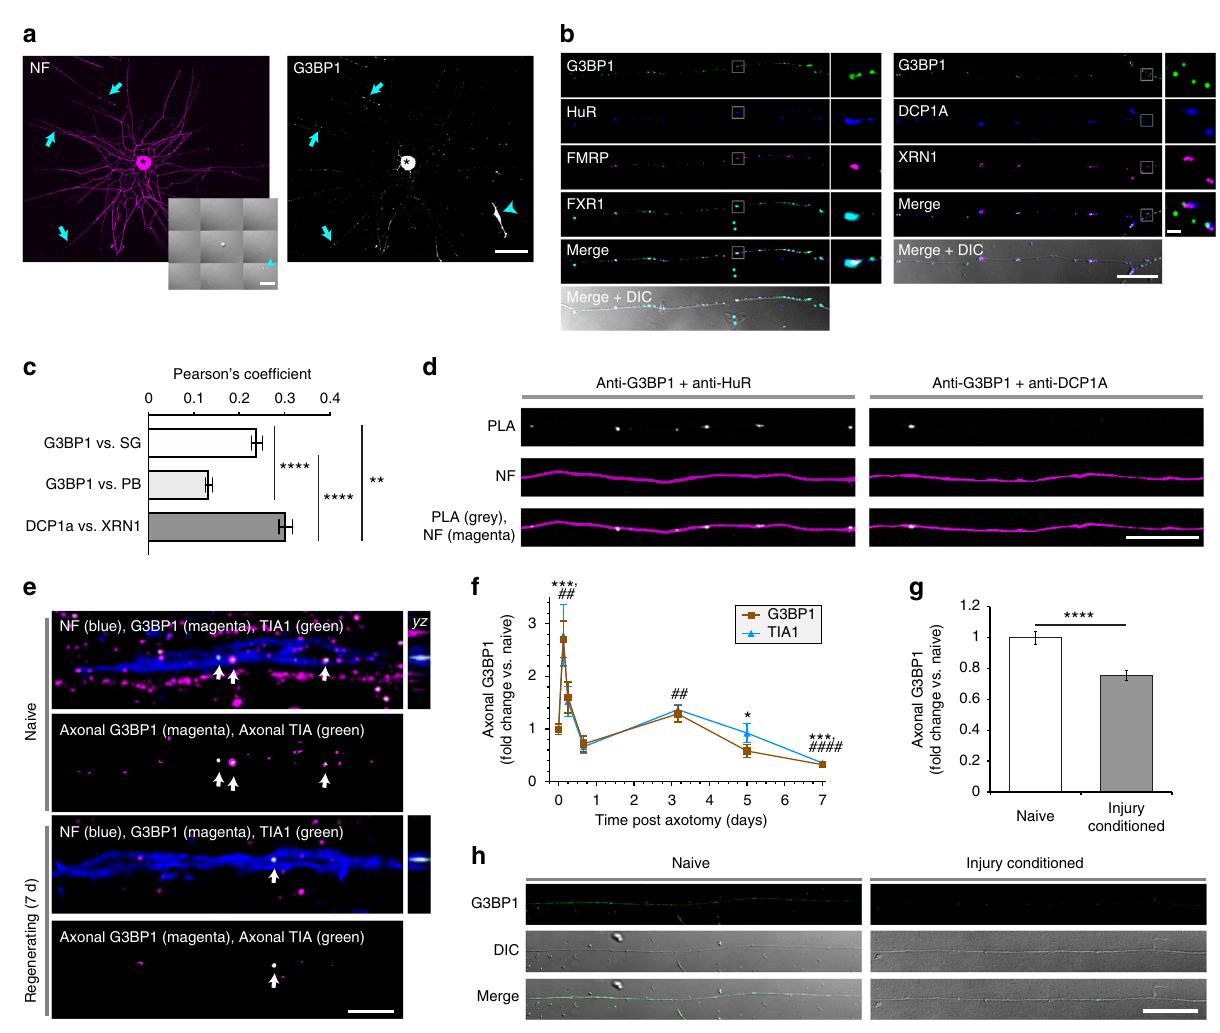
Fig. 1 G3BP1 localizes to axons in stress granule-like aggregates. a Immuno fl uorescence for G3BP1 shows signals in the cell body (asterisk) and axons (arrows) of a cultured DRG neuron; arrowheads indicate Schwann cell with prominent G3BP1 immunoreactivity visible in the inset DIC image. Previous work has shown that neurites of these adult DRG neurons have axonal features and lack dendritic features 49 ; we will use ‘ axon ’ for describing these hereafter [scale bar = 50 µ m]. b , c Single planes for axons of naive DRG cultures co-labeled for indicated proteins are shown; box represents the area for high magni fi cation insets to right ( b ). Axonal G3BP1 shows higher colocalization coef fi cients for SG than PB proteins by Fisher ’ s Z transformation ( c ; N ≥ 30 axons over 3 repetitions; ** p ≤ 0.01, **** p ≤ 0.001 by one-way ANOVA with Tukey HSD post-hoc) [scale bar = 10 µ m for large panels, 1 µ m for insets]. d PLA shows higher colocalization for G3BP1 and HuR than G3BP1 and DCP1A (G3BP1 + HuR PLA = 0.038 ± 0.003 and G3BP1 + DCP1A PLA = 0.027 ± 0.002 signals/ µ m 2 ; N ≥ 40 neurons over 6 repetitions, p = 0.016 by Student ’ s t -test) [scale bar = 20 µ m]. e , f Confocal images for G3BP1 and TIA1 in naive and 7 d post-injured ( ‘ regenerating ’ ) sciatic nerve are shown ( e ). Upper image panels of each pair show G3BP1 and TIA1 merged with NF signals in single plane. Lower panels of each pair show XYZ for G3BP1 and TIA1 signals that overlap with NF across the Z stack Quantitation of axonal G3BP1 and TIA1 signals are shown ( f ) as mean ± SEM ( N = 6 animals; * p ≤ 0.05, *** p ≤ 0.001 for G3BP1 and ## p ≤ 0.01, #### p ≤ 0.0001 for TIA1 by Student ’ s t -test for vs. naive) [scale bar = 5 µ m]. g , h Quanti fi cation of G3BP1 levels ( g ) and G3BP1 immuno fl uorescence ( h ) in axons of DRGs cultured from naive vs. 7 d injury-conditioned animals are shown (mean ± SEM for N ≥ 66 neurons over 3 repetitions; *** p ≤ 0.001 by Student ’ s t -test) [scale bar 20 µ